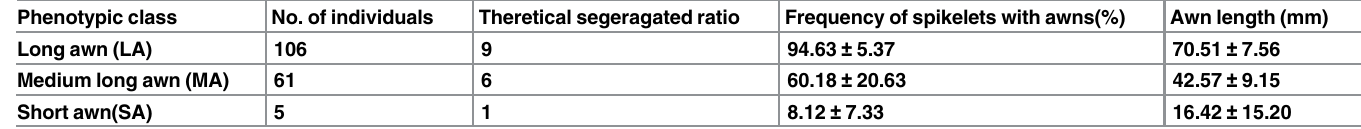
Table 2. Segregation of awn phenotype, length and rate in an F 2 population of the cross between awned NIL lines BM33a and BM38a. Phenotypic class